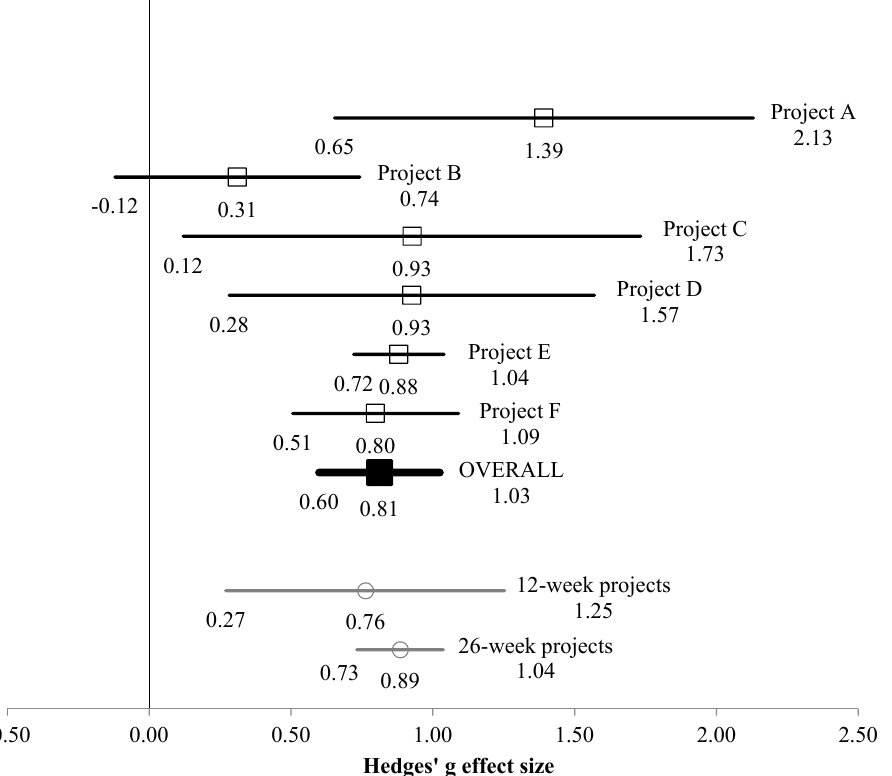
Figure 1. Multi-study e ff ect sizes ( ± 95% upper and lower limits) for start to end of intervention changes Figure 1 . Multi-study effect sizes (±95% upper and lower limits) for start to end of intervention Int. J. Environ. Res. Public Health 2019 , 16 , x across the whole sample. changes across the whole sample